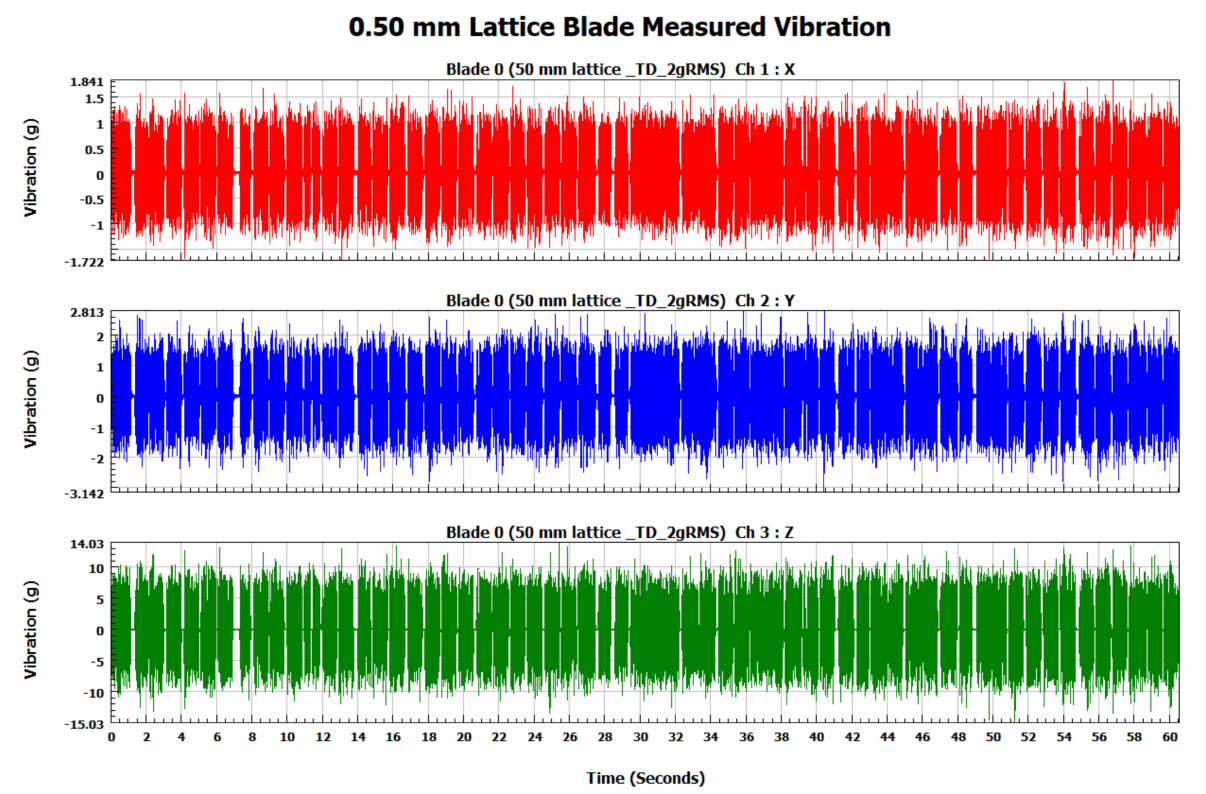
Figure 12. The 0.50 mm lattice blade measured vibration signal in the time domain.